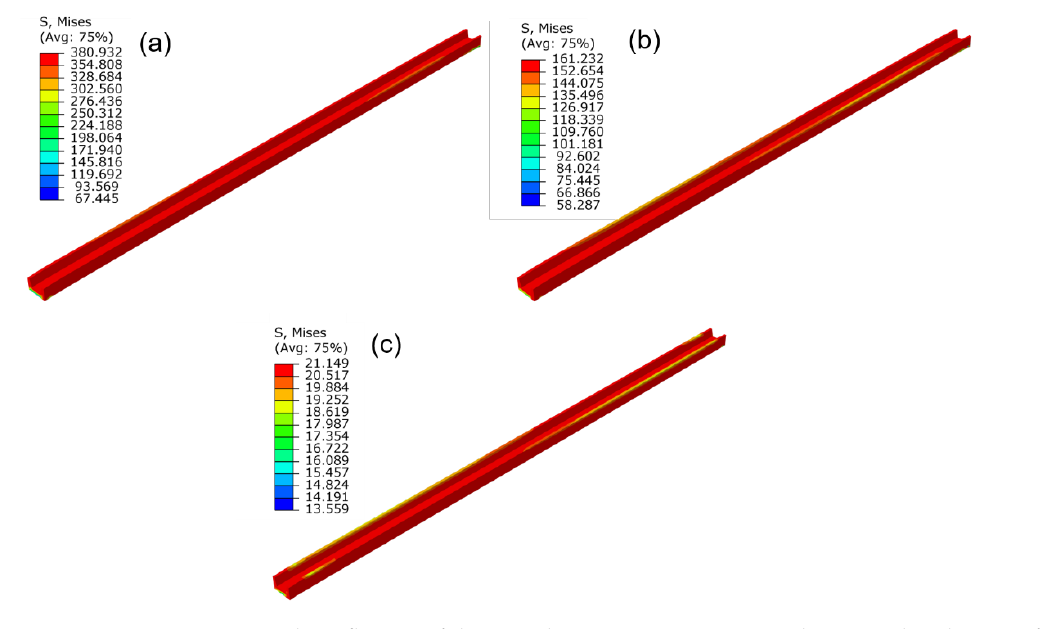
Figure 15. The influence of the straightening temperature on the stress distribution of the profile: ( a ) 500 °C; ( b ) 600 °C; ( c ) 700 °C (stretch strain 1.5%, holding time 600 s).